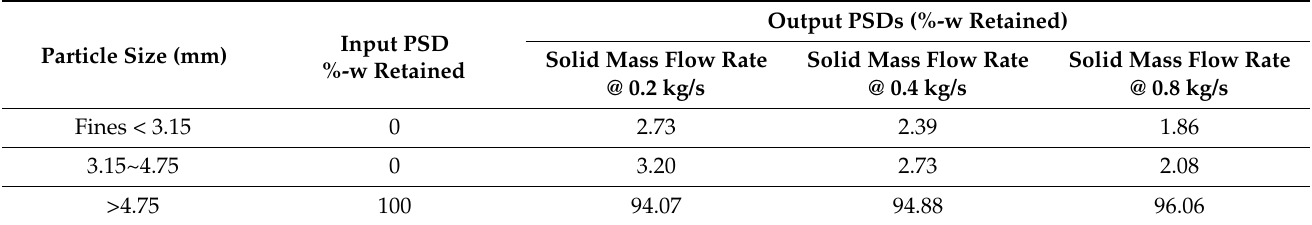
Table 9. Degradation of aged pellets at an air flow rate of 0.27 kg/s with bends in proximity.